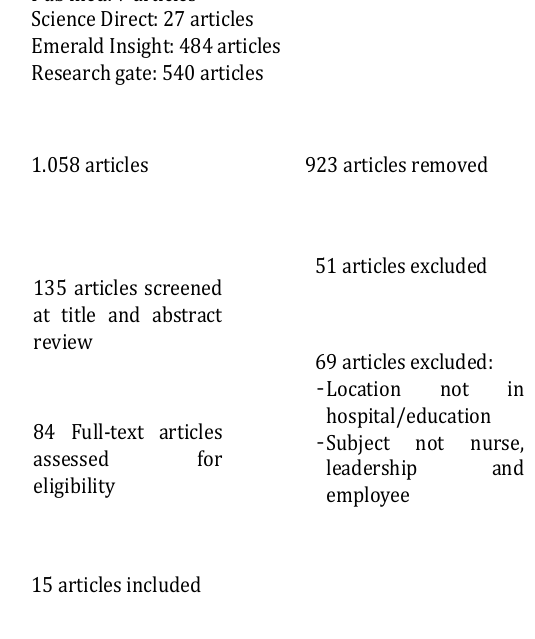
Figure1. Prism flow